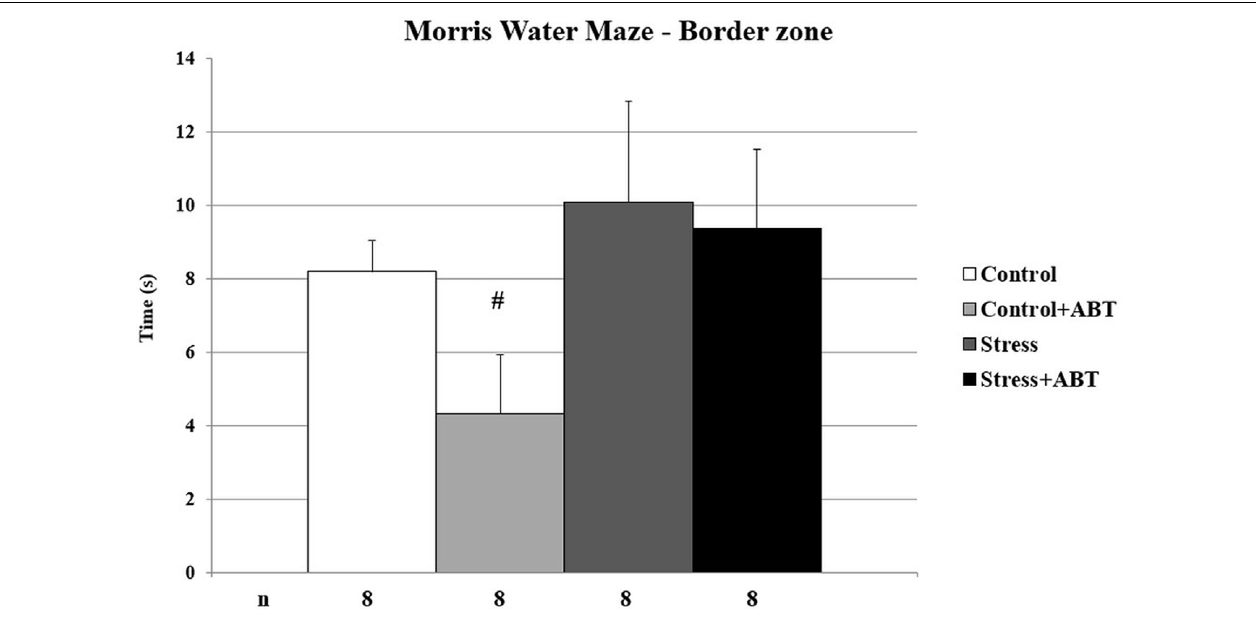
FIGURE 3 | Effects of chronic stress and long-term ABT-239 pre-treatment on border zone latency in MWM task. Each column represents the mean ± SEM of nine trials (three trials per day for 3 days) obtained from n rats indicated at the bottom of the figure. Control rats pre-treated with ABT-239 spent significantly less time in the border zone than the stressed group ( # p <